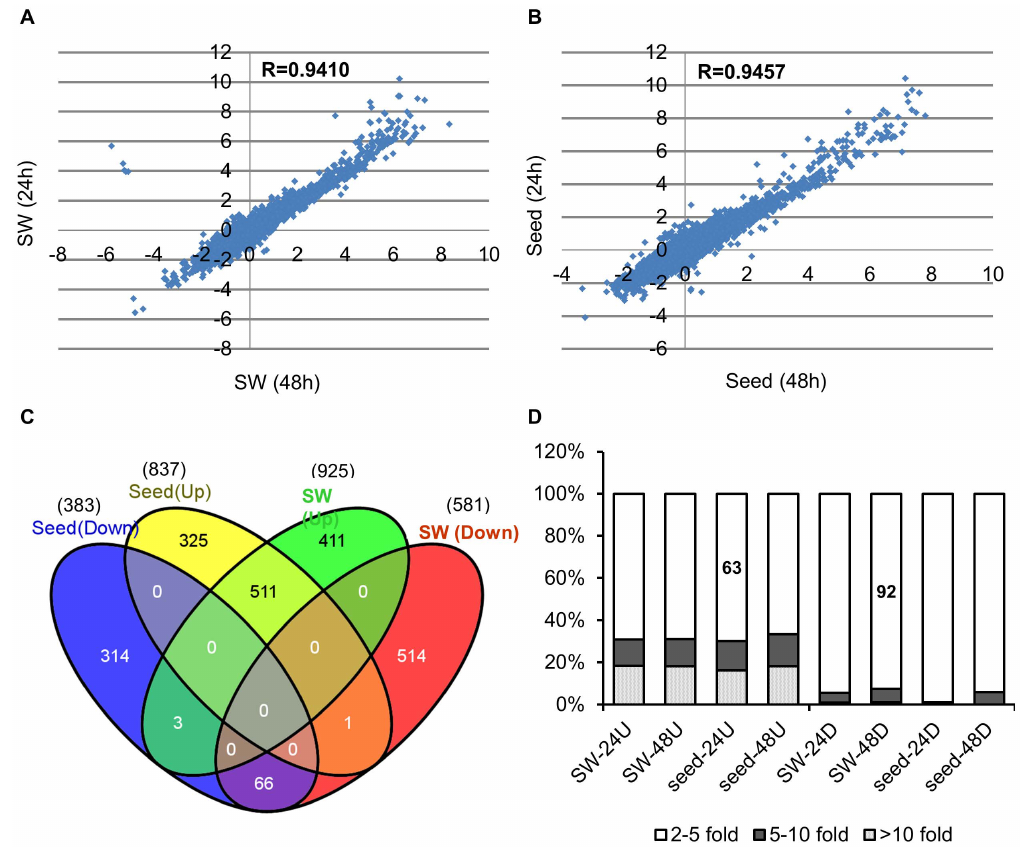
Figure 1. Expression characteristics of heat-stressed siliques. Correlation analysis of the SW (A) and seed (B) transcriptomes after 24 h and 48 h recovery times. (C) Venn diagrams showing the intersection of differentially expressed transcripts in the heat-stressed SW and seed. (D) Comparison of increased or decreased transcripts in different samples. Abbreviations: 24 U/48 U and 24 D/48 D indicate up-regulated and down- regulated genes after the 24 h/48 h recovery times either in the SW or seeds.